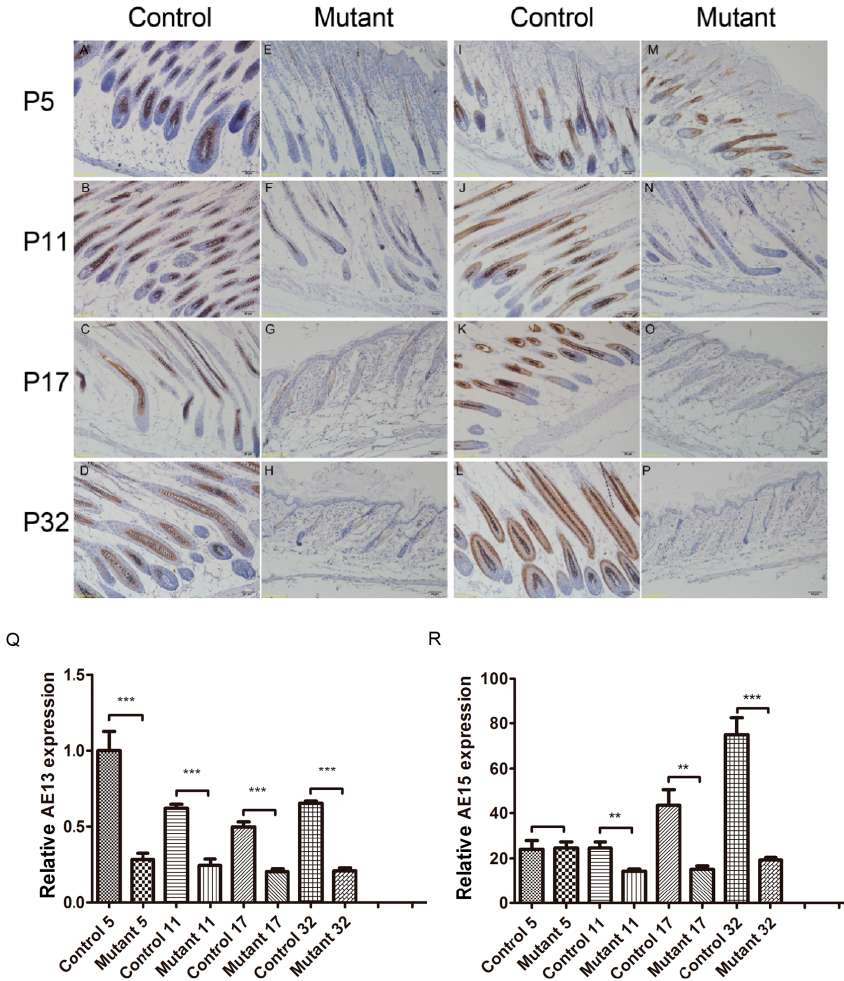
Figure 4. Epithelial PP2Ac α signaling is required for the keratinized cortex and IRS in hair differentiation. The antibody to AE13 stains the precortex and cortex of the hair keratin in control mice (panels A – D ) and mutant mice (panels E – H ). The antibody to AE15 stains the IRS and medulla of hair follicles in control mice (panels I – L ) and mutant mice (panels M – P ). Scale bars = 50 μ m; ( Q , R ) Statistical analysis indicated that AE13 expression in mice skin was significantly reduced in all phases. AE15 expression was significantly reduced in all phases except in the P5 phase. n = 3 in each group, ** p < 0.01, *** p < 0.001.